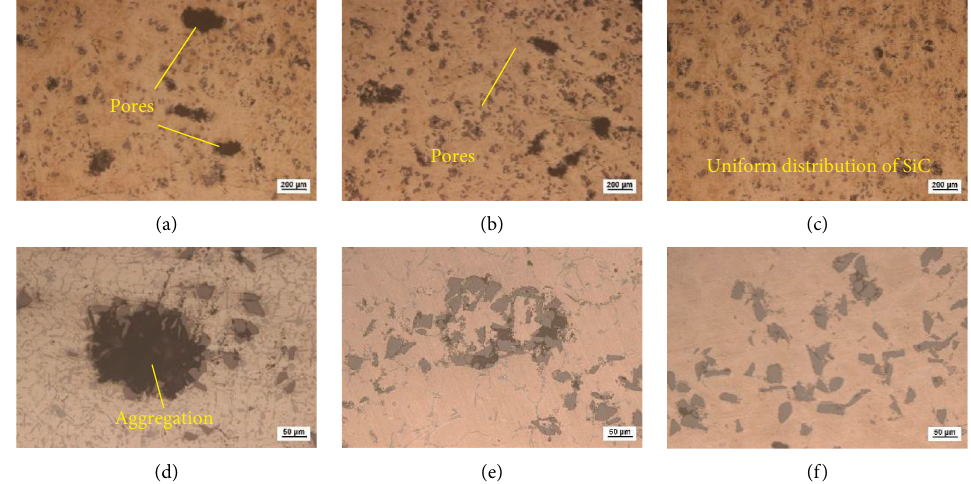
Figure 3: The effects of stirring temperature on the dispersion uniformity of SiC particles (a, d) 750 ° C; (b, e) 700 ° C; (c, f) 650 ° C.